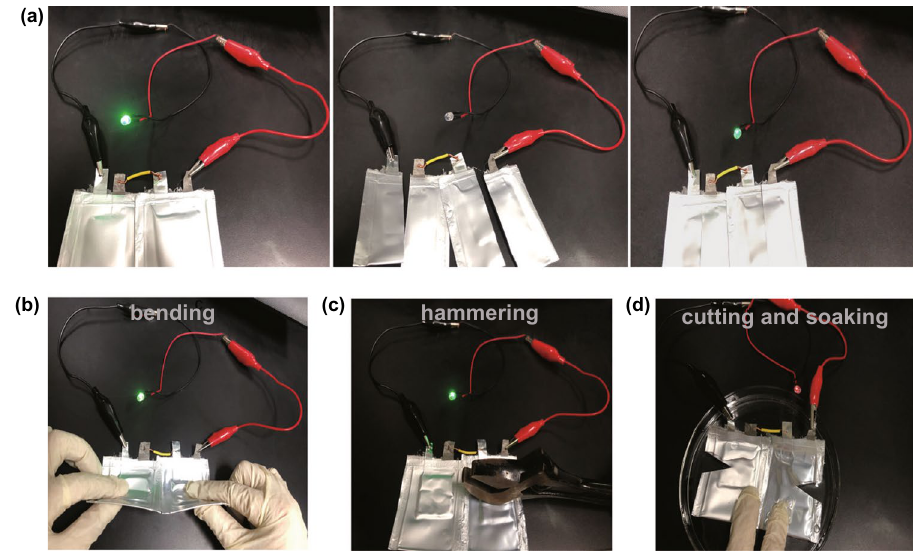
Fig. 7 Optical images of destructive tests of the two pouch cells in series including a cutting and reconnecting test, b bending test, c hammering test and d cutting and soaking